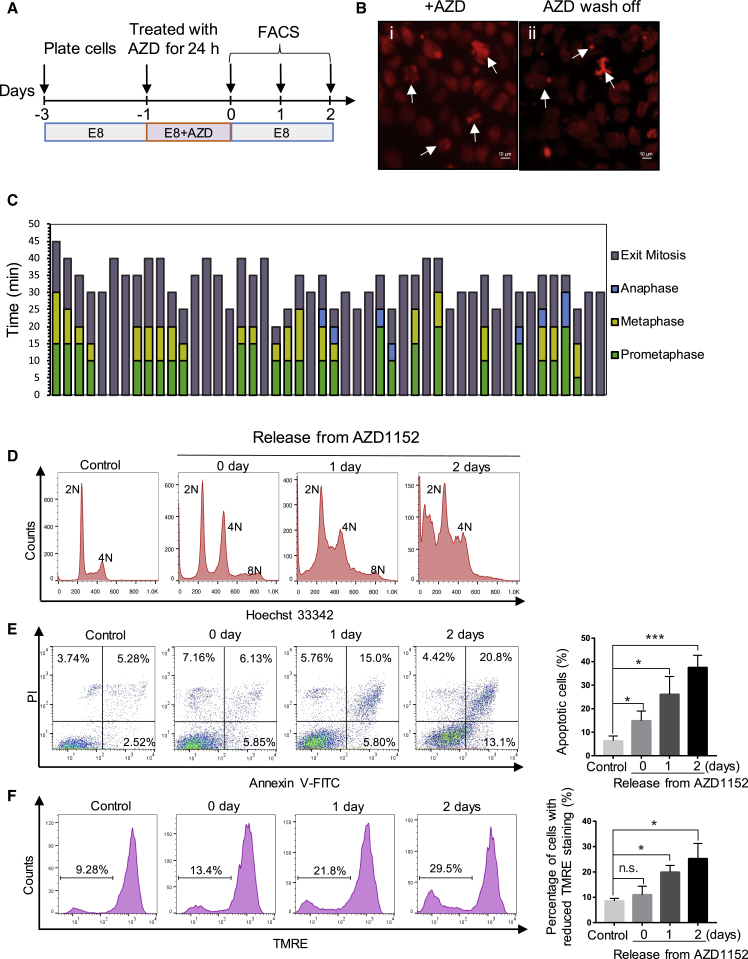
Abnormal Mitosis and Apoptosis Induced by Aurora Kinase B Inhibitor AZD1152(A) Schematic timeline of the experiment.(B) Images of H2B-mCherry H9 cells treated with AZD1152 (AZD) and after AZD wash-off. Arrows indicate severely misaligned chromosomes.(C) Quantitative analysis of the length of each phase of the mitosis in AZD-treated cells (n = 48) based on live imaging. The prometaphase, metaphase, and anaphase are represented by different colors. Many cells condensed chromosomes but did not show distinguishable mitotic phases, thus represented as “Exit mitosis.”(D–F) Flow-cytometric analysis of cell cycle (Hoechst 33342, D), apoptosis (Annexin V-PI staining, E), and mitochondrial membrane potential (TMRE, F) at different time points after H9 cells were released from 24-h AZD treatment (error bars are shown as ±SEM of three independent biological experiments; n.s., not significant; ∗p < 0.05, ∗∗∗p < 0.001, based on unpaired Student's t test).